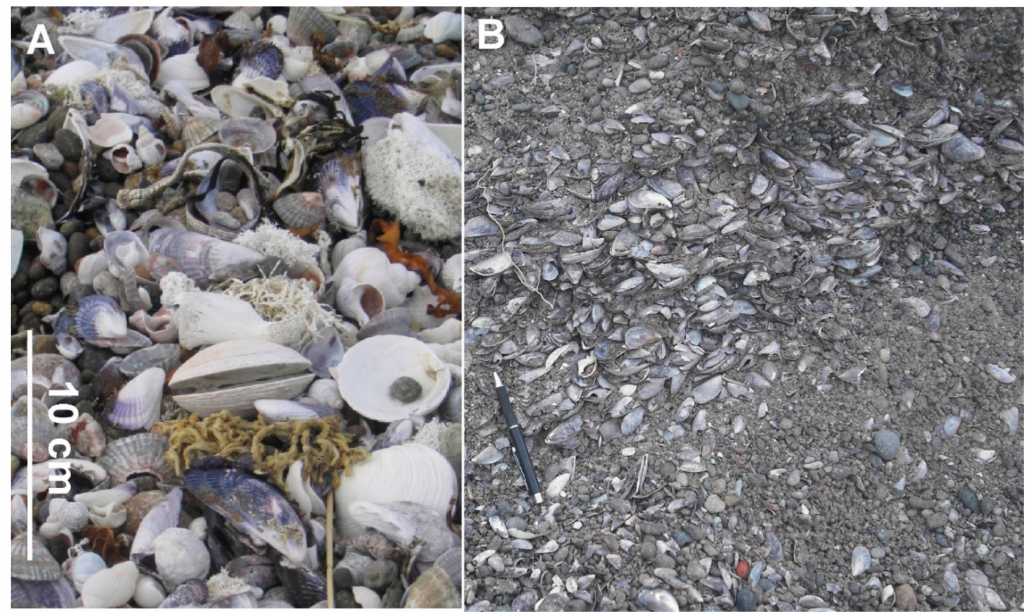
Figure 2. ( A ) Examples of shell accumulation over the Patagonian beaches; ( B ) examples of fossil storm